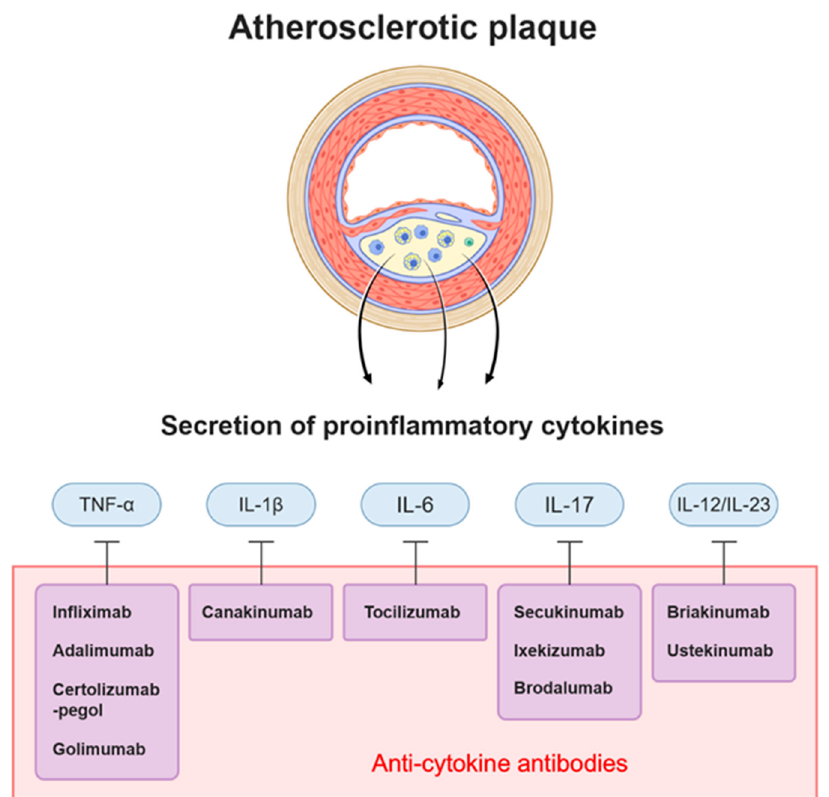
Figure 2. Antibodies targeting cytokines and cytokines acting on atherosclerotic plaque. Atherosclerotic plaque consists of lipid, apoptotic cells, immune cells, smooth muscle cells, and endothelial cells. These cells induce inflammation by secreting specific cytokines. Among them, IL-1 β , TNF- α , IL-17, IL-6, and IL-12/23 are under investigation as therapeutic targets for atherosclerosis, and a number of antibodies have been developed to target each cytokine.